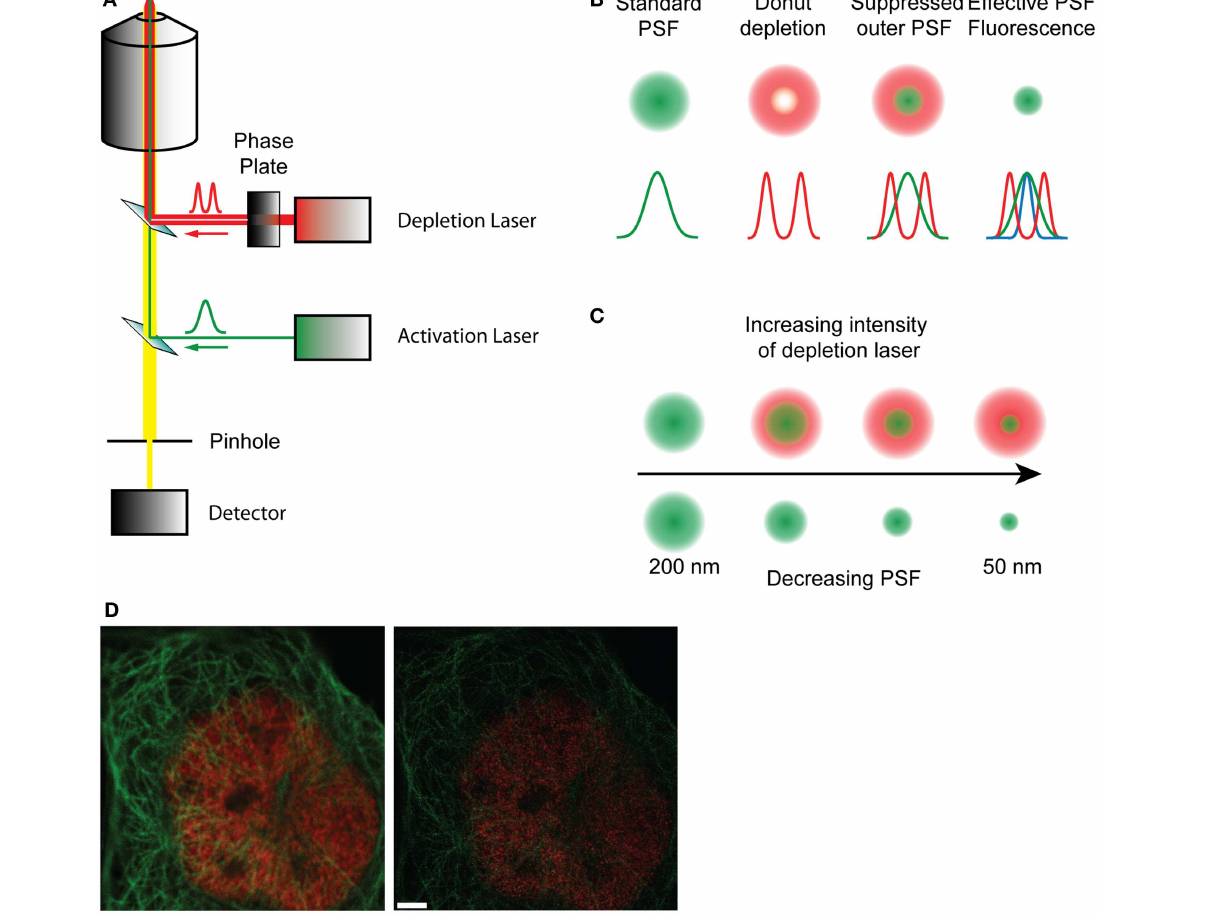
FIGURE 2 | (A) Schematic diagram of a STED microscope setup.The activation laser is overlaid with the depletion laser that passes through a phase plate, and focused to a focal point in the sample.The fluorescence emitted by the sample passes through a pinhole and is collected in the detector. (B) Representation of how the effective point spread function is formed by the overlap of the standard PSF and the depletion PSF. (C) With